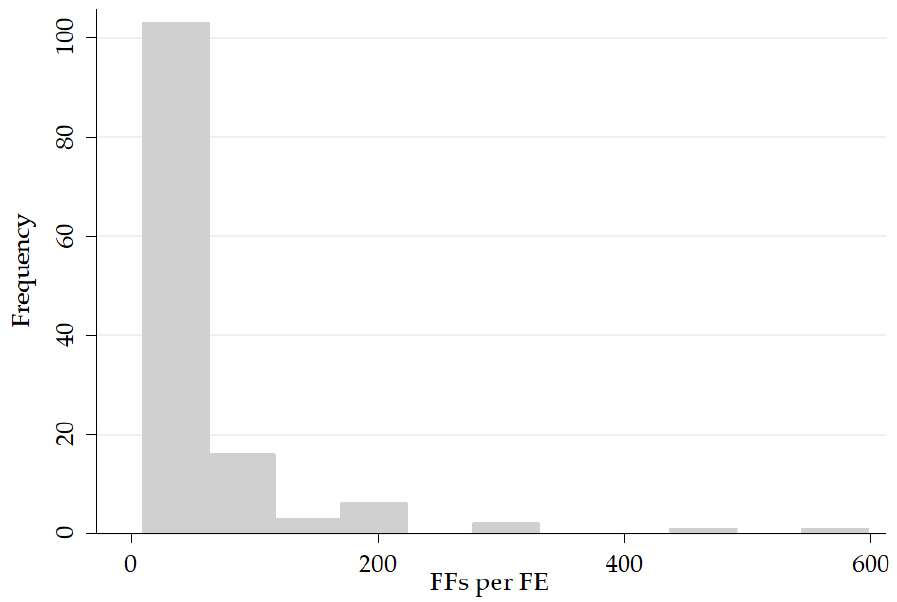
Figure 3. Frequency distribution (histogram) of flood fatalities (FFs) per flood event (FE) in the study period 1882–2021.